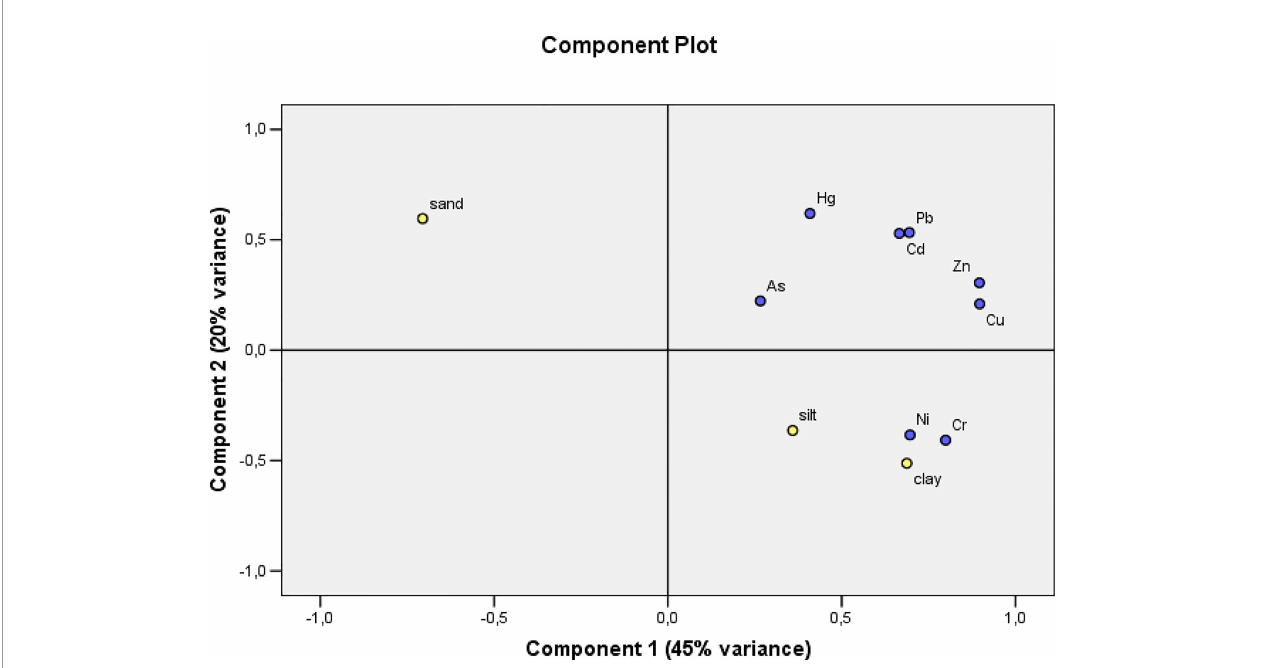
FIGURE 5 | Scatter plot of Principal Component Analysis on standardized MTEs concentrations and grain size data in the four sediment cores; elements affected by anthropogenic enrichment are recognizable because they are not correlated to the fi ne sediment fractions (Romano et al.,